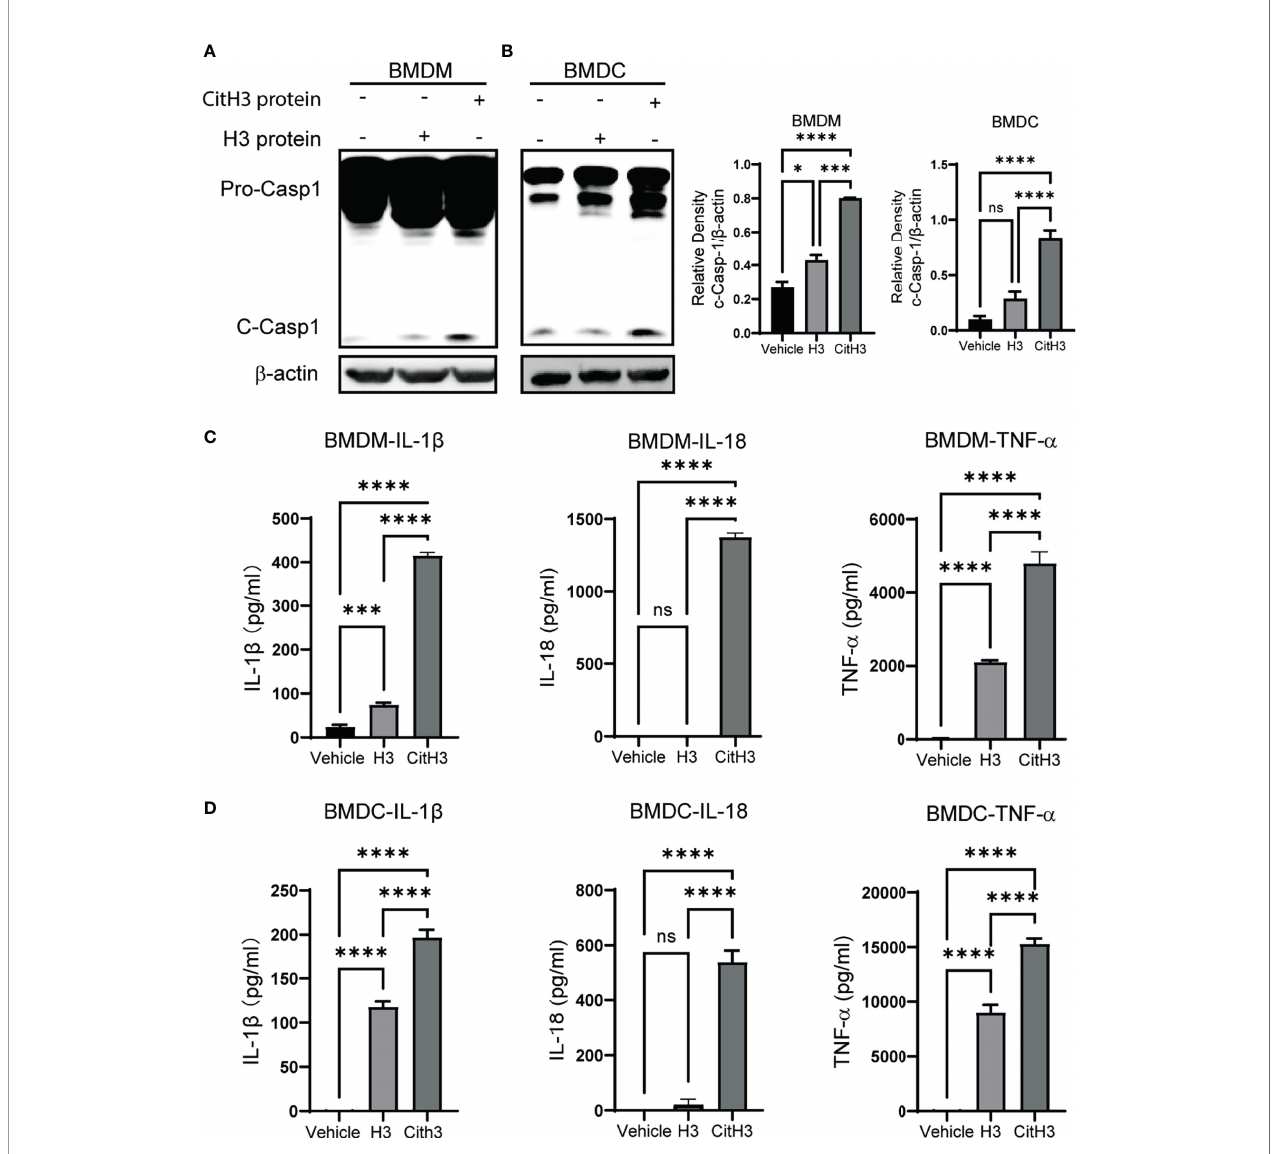
FIGURE 4 | CitH3 induces activation of Caspase-1 in BMDMs and BMDCs. BMDMs and BMDCs were isolated from WT mice. Representative Western blot images and densitometry quanti fi cation of activation of Caspase-1 in (A) BMDMs (n = 3) and (B) BMDCs (n = 5) after treatment with vehicle, H3 or CitH3 for 5 h. Concentrations of IL-1 b , IL-18 and TNF- a in the supernatant of (C) BMDMs (n = 4/group) and (D) BMDCs (n = 5/group) after treatment with vehicle, H3 or CitH3 for 5 h. Results are representative of more than 3 independent experiments. Data are expressed as mean ± SEM. *P < 0.05, ***P < 0.001, ****P < 0.0001. ns, not signi fi cant; SEM, standard error of the